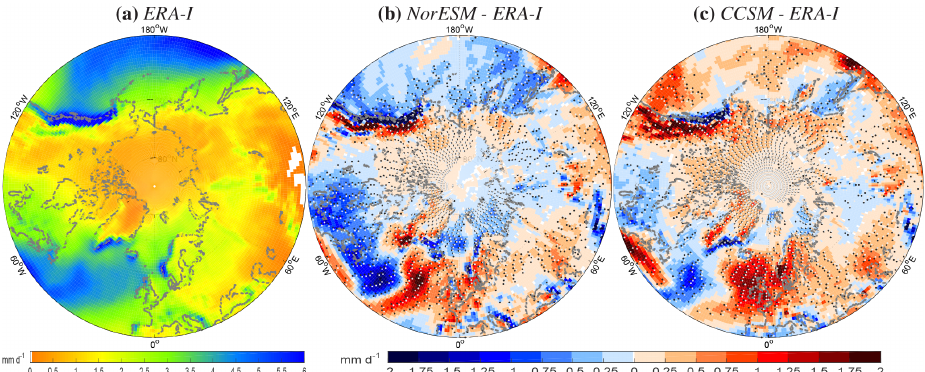
Figure 9. Precipitation average for SOND 1979–2005 in (a) ERA-I and bias of (b) NorESM and (c) CCSM compared to ERA-I. Alternating black and white dots in panels (b) and (c) mark regions of significant bias at a 95% confidence